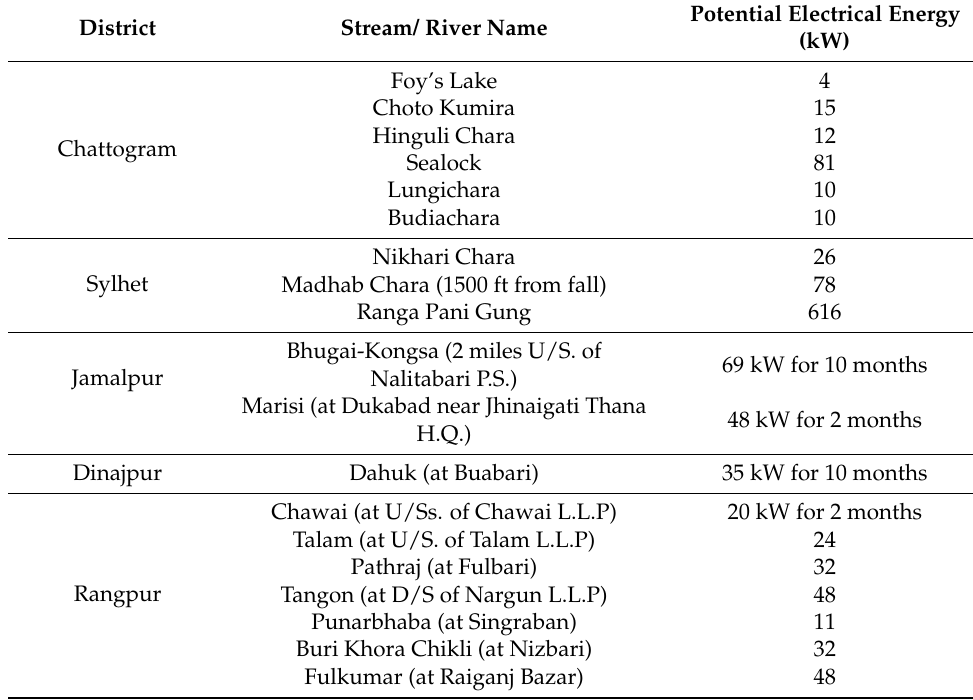
Table 1. List of potential small hydroelectricity sites in Bangladesh